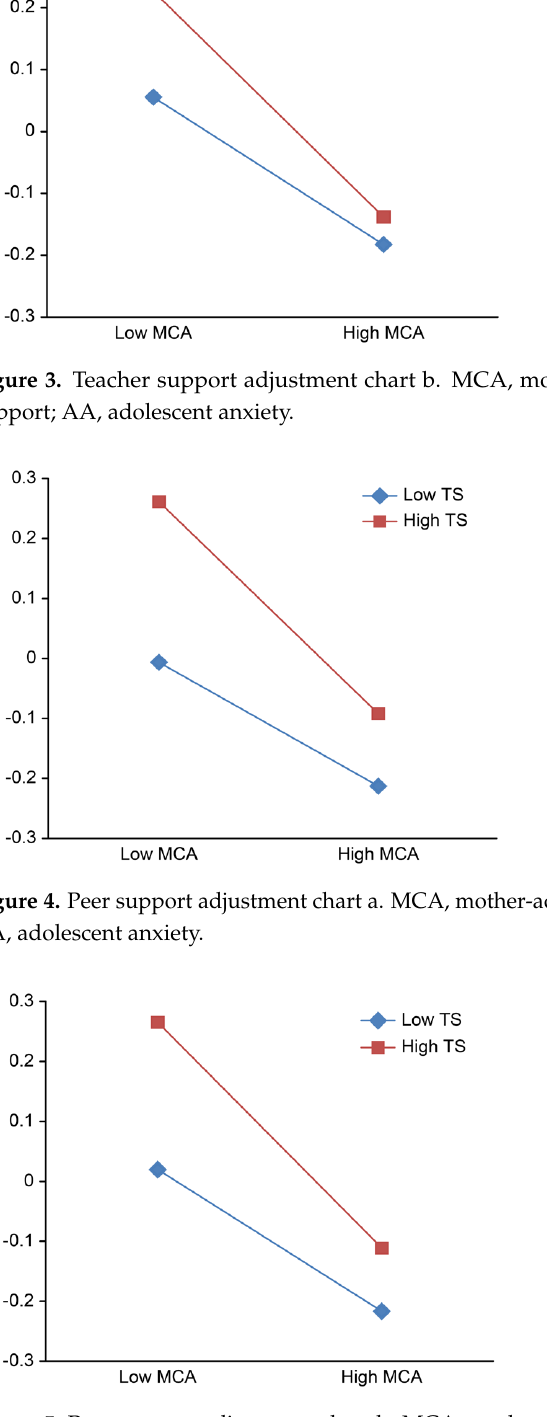
Figure 5. Peer support adjustment chart b. MCA, mother-adolescent attachment; PS, peer support; AA, adolescent anxiety.